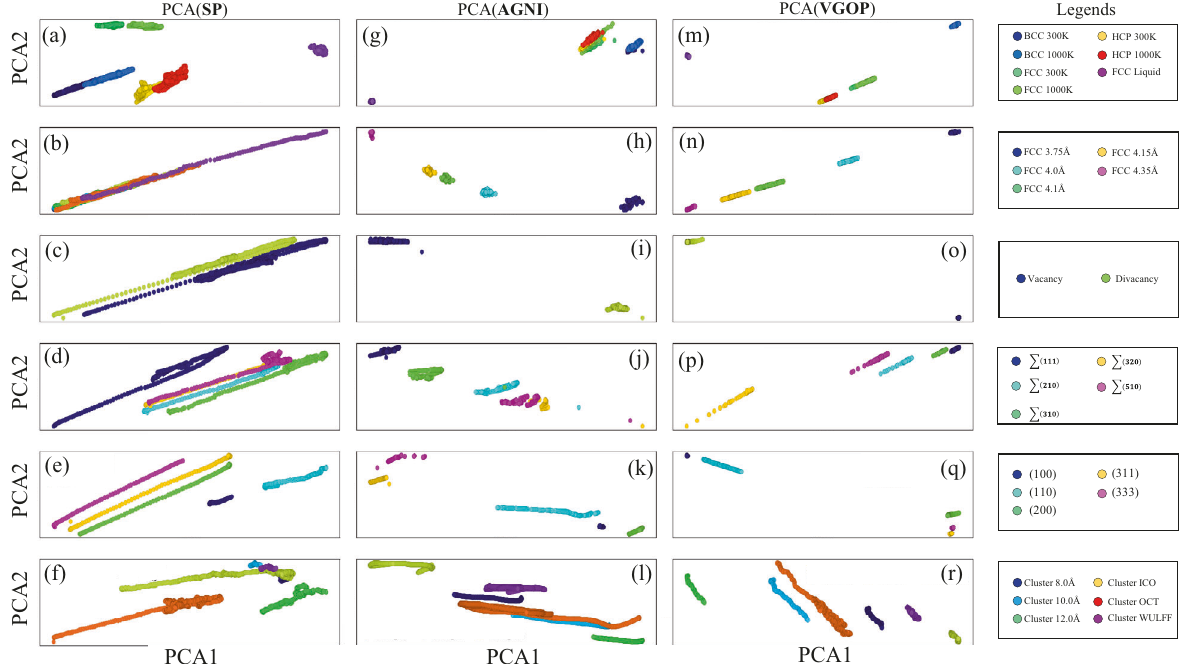
Fig. 7 Spatial clustering of Al between the Steinhardt order parameter, AGNI, and VGOP. Comparison of the PCA reduction of three different methods, using a robust aluminum database: (column 1) the Steinhardt order parameter, (column 2) the AGNI crystal fi ngerprint, and (column 3) the VGOP. Each row represents a unique subset of the aluminum con fi guration space. Colors are uniform across the columns. Each PCA subplot ’ s axis have been normalized to the data present within the plot to allow for better visualization of the data. Row labeling is as follows: a , g , m Bulk, b , h , n Bulk with strain, c , i , o Bulk with vacancies, d , j , p Grain boundaries, e , k , q Surfaces, and f , l , r Clusters.